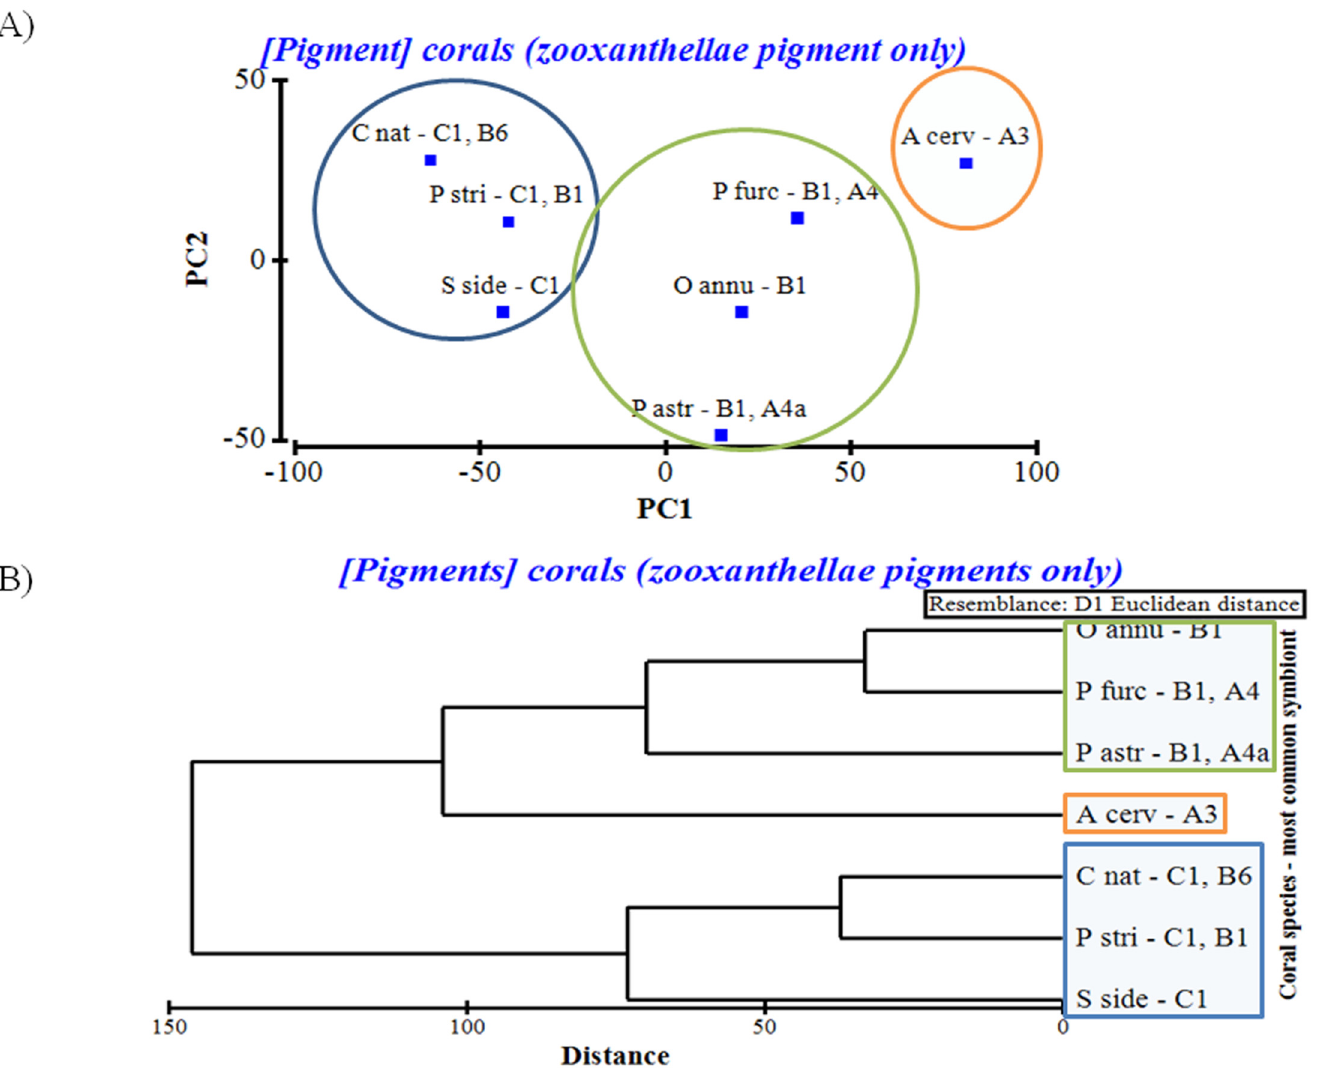
Fig 4. Multivariate statistical analysis of coral pigments. A) PCA and B) HCA showing the grouping of the seven coral species based on the concentration of the main photosynthetic pigments (chlorophylls, carotenes and xanthophylls). The most common symbiont clade found in each coral species (based on published literature) is shown next to the coral species